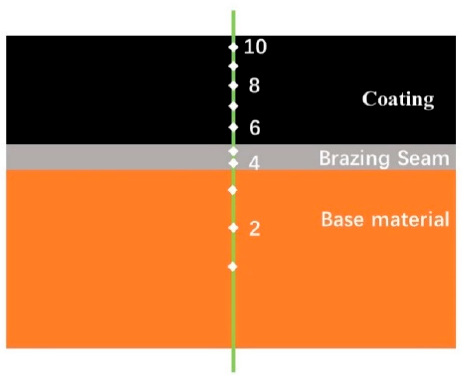
Figure 3. Schematic diagram of the hardness position of the composite coating.